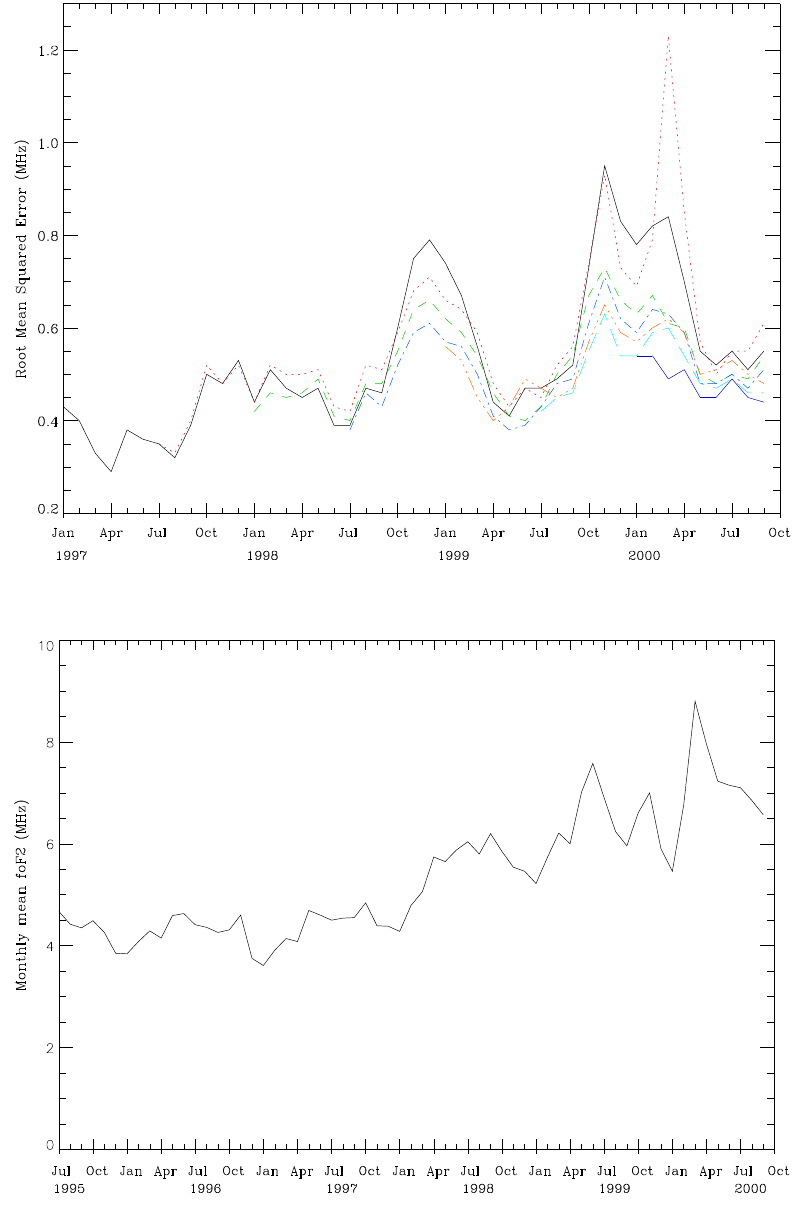
Fig. 5. Monthly mean fo F2 values from July 1995 to October